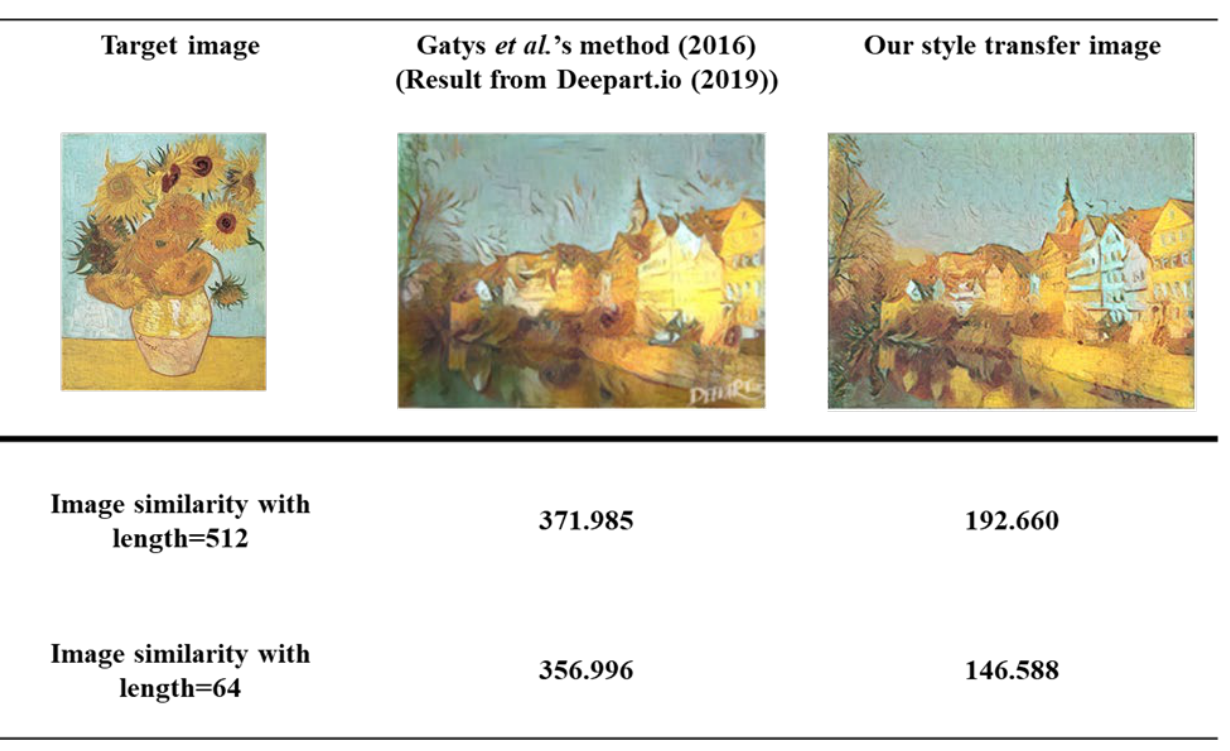
Figure 19. Image similarity with the variance of the images.